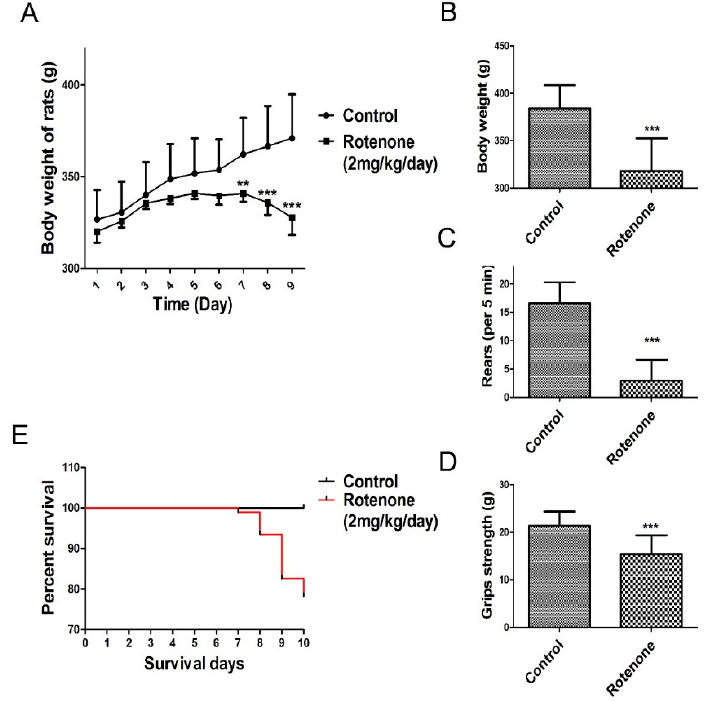
Figure 2. Changes in body weight and behavioral parameters of the PD model. The parameters are presented as the mean ± SD, * compared to control, (** p < 0.01, *** p < 0.001, rotenone: n = 92, control: n = 10). ( A ) Body weight change during rotenone treatment from day 1 to day 9; ( B ) Day 10 body weight change during rotenone treatment; ( C ) Rearing behavior result after 10 days of rotenone treatment; ( D ) Grip strength result after 10 days of rotenone treatment; ( E ) Survival of during 10 days rotenone treatment.